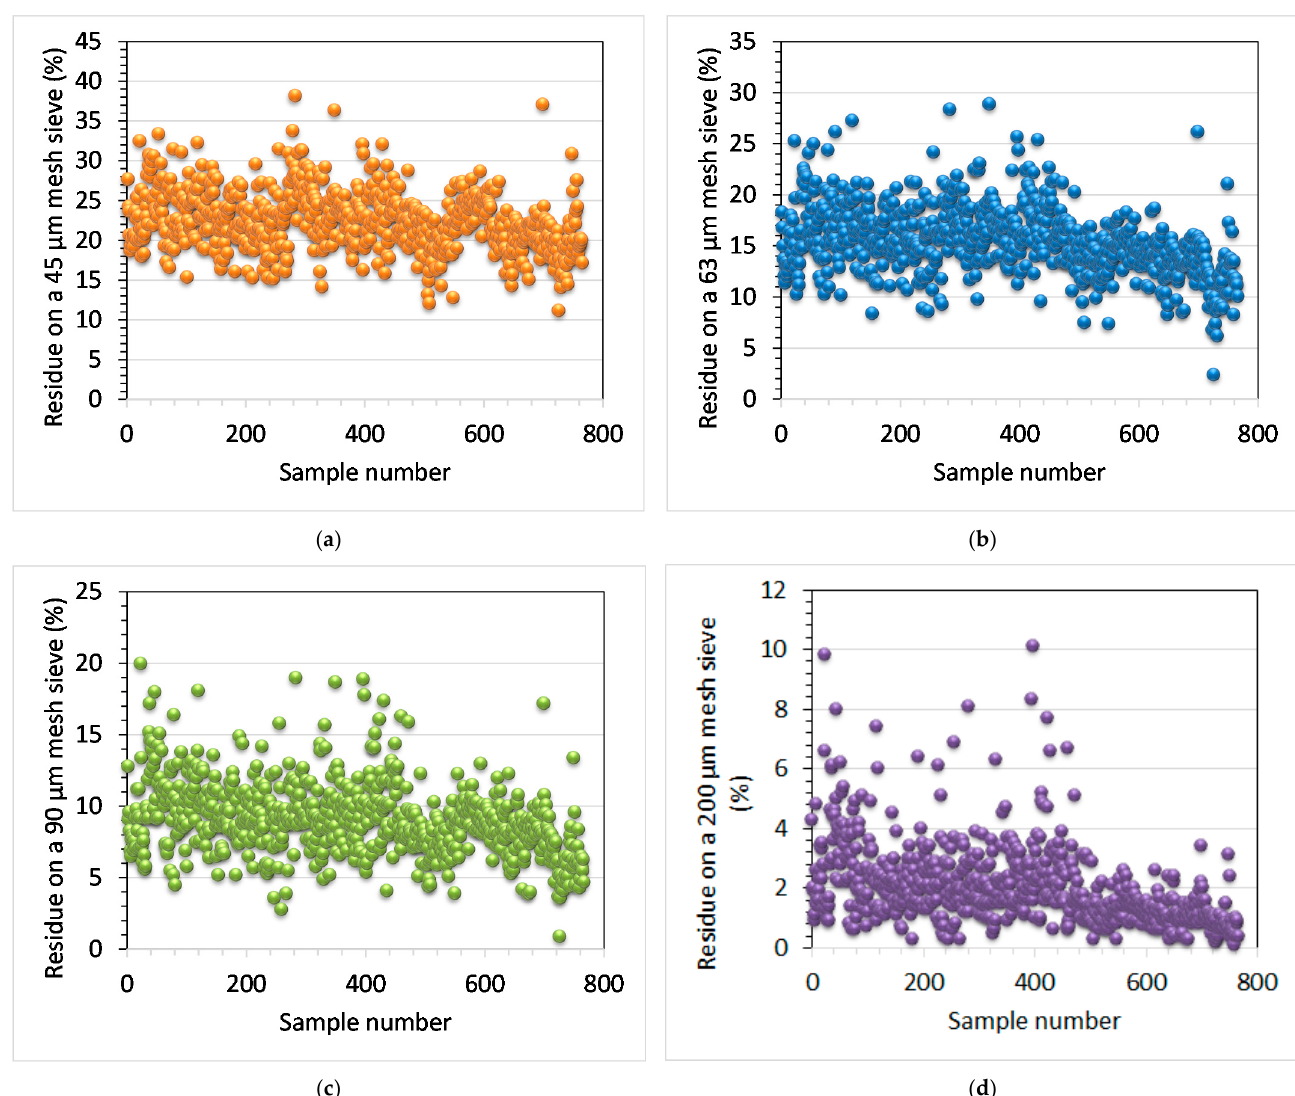
Figure 2. Residue of 765 samples, collected for ten years, on a 45 µm; 63 µm; 90 µm and 200 µm mesh sieve: ( a ) 45 µm; ( b ) 63 µm; ( c ) 90 µm; ( d ) 200 µm.